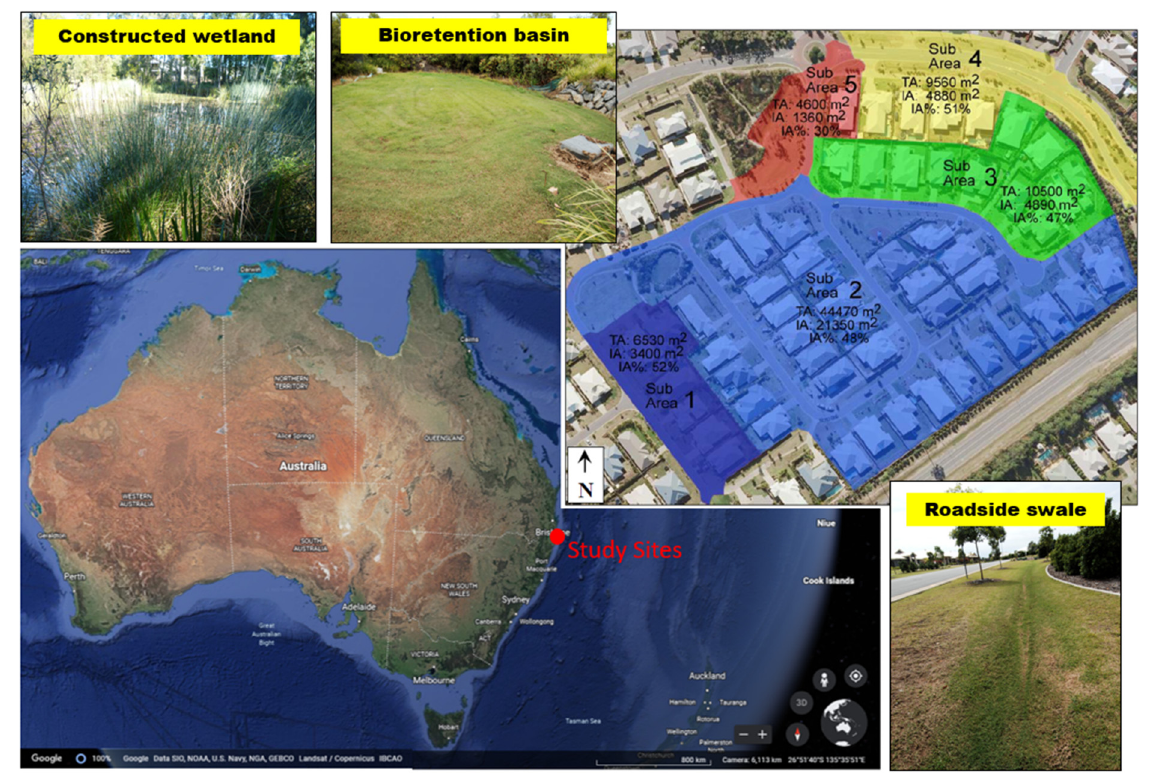
Figure 1. Study site. TA: total area; IA: impervious surface area; IA%: impervious surface percentage. Stormwater runoff from sub-area 1 primarily contributes to B. After passing through B, the stormwater enters the constructed wetland. Stormwater runoff from sub-area 2 and sub-area 3 directly flows to W. Sub-area 4 distributes flow to roadside swales, while sub-area 5 is the bypass of W, which does not receive treatment from any of the WSUDs.